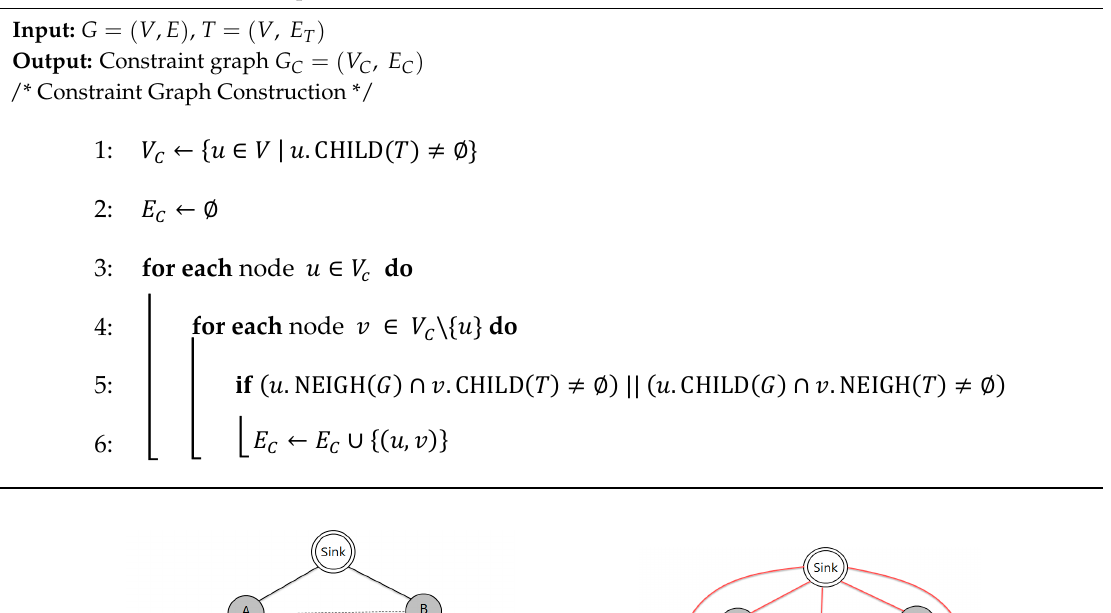
Algorithm 1. Constraint Graph Construction